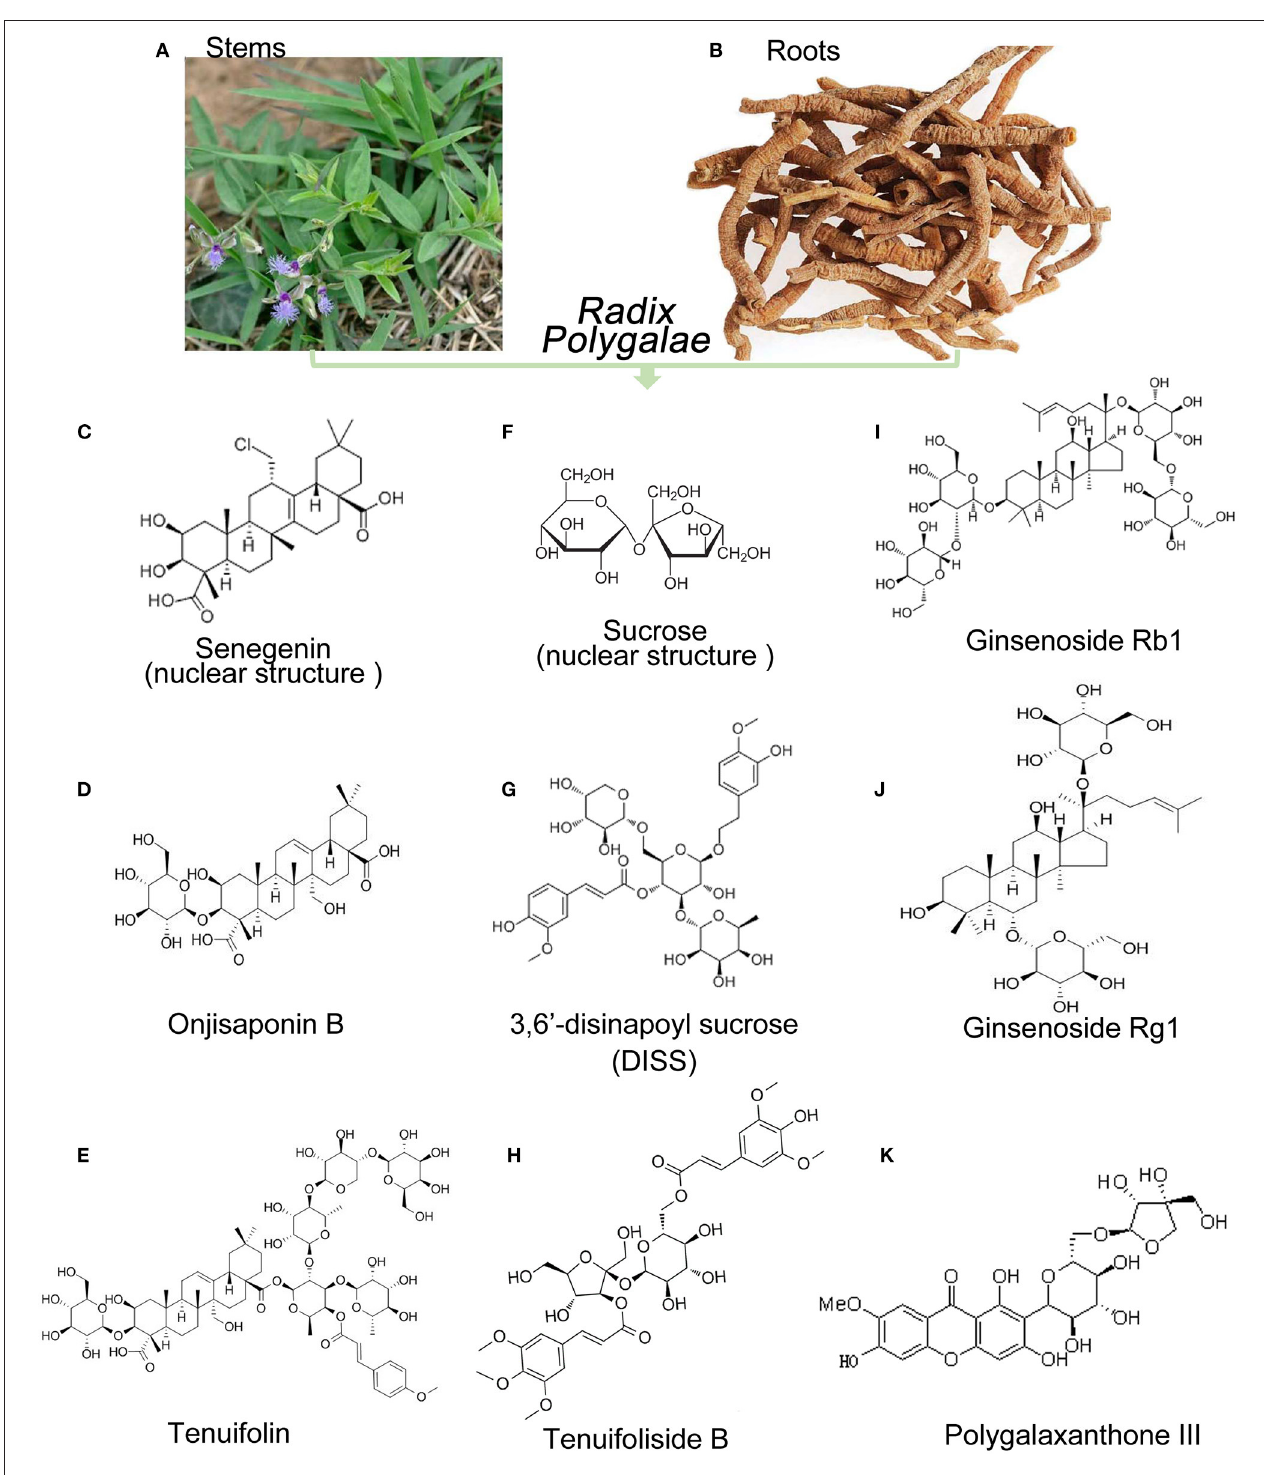
FIGURE 1 | Sources and main chemical structure of the representative components of Radix Polygalae. (A,B) Stems and roots of RP; (C) senegenin as the mother nuclear structure of polygala saponins; (D) onjisaponin B; (E) tenuifolin; (F) sucrose as the mother nuclear structure of polygala saponins; (G) 3,6 ′ -disinapoyl sucrose 3,6 ′ (DISS); (H) tenuifoliside B; (I) ginsenoside Rb1; (J) ginsenoside Rb1; (K) polygalaxanthone III.